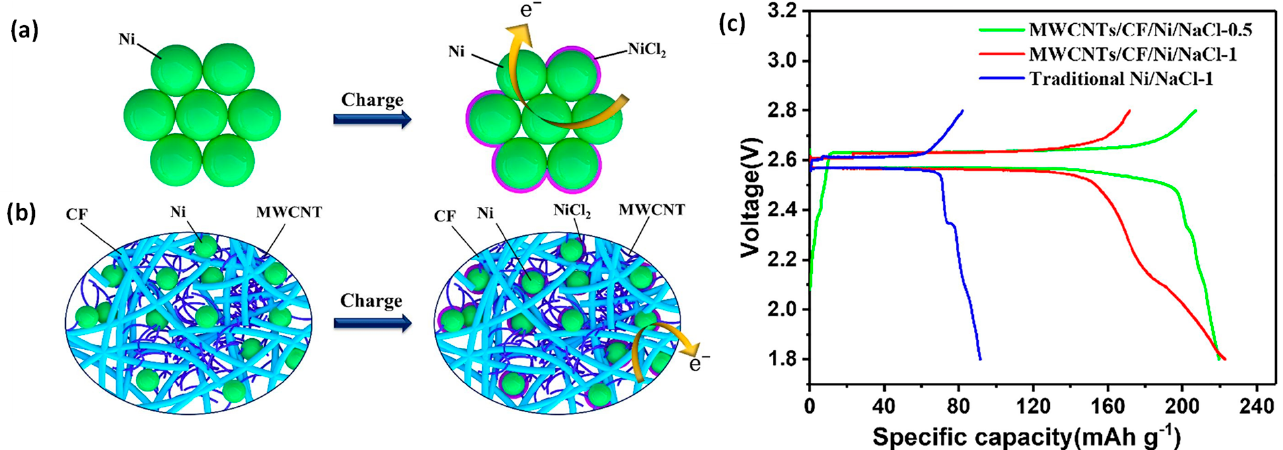
Figure 5. Schematic illustration of the charging process for ( a ) traditional Ni particles and ( b ) the MWCNTs/CF/Ni/NaCl cathode. ( c ) Typical voltage profiles of the traditional Ni/NaCl and MWCNTs/CF/Ni/NaCl cathodes with Ni/NaCl molar ratio of 0.5 or 1 (adapted with the permission from Elsevier).